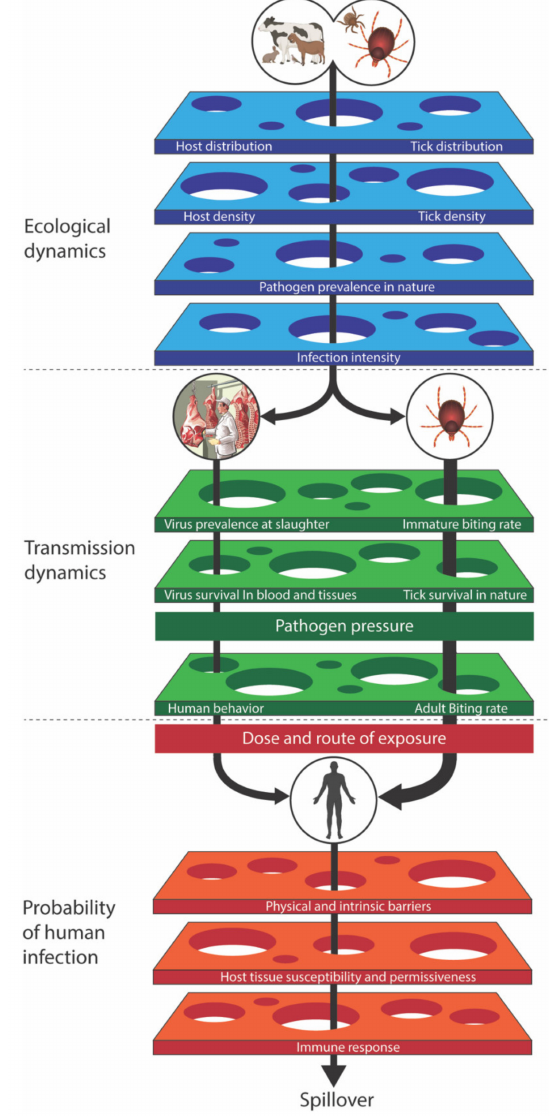
Figure 2. Spillover percolation model of di ff erent barriers to CCHFV spillover and opportunities to intervene (based on Plowright et al., 2017) [61]. The risk of CCHFV spillover is determined by the ecological dynamics of infection in the tick and animal host (blue barriers), human epidemiology / behavior (green barriers), and within-host biological factors (orange barriers) that influence exposure outcome in humans. CCHFV must overcome all of the barriers before spillover can occur; thus, each barrier o ff ers intervention opportunities to prevent human disease. The distribution and intensity of infection (virus levels) in tick vectors and animal hosts, virus release from ticks and animal hosts, and CCHFV and tick survival determine the pathogen pressure (the amount of virus that is available to humans at a given point in time and space). Pathogen pressure then interacts with human behavior and the tick vector to determine the likelihood, dose, and route of human exposure. The thickness of the arrows represents the likelihood of spillover to humans (tick > livestock-associated exposure). The probability of human infection is determined by the within-host factors. Once spillover has occurred, human-to-human transmission in a household or nosocomial setting can occur as well (not depicted). In this case, barrier parameters, such as virus dose, route, and human behavior, still